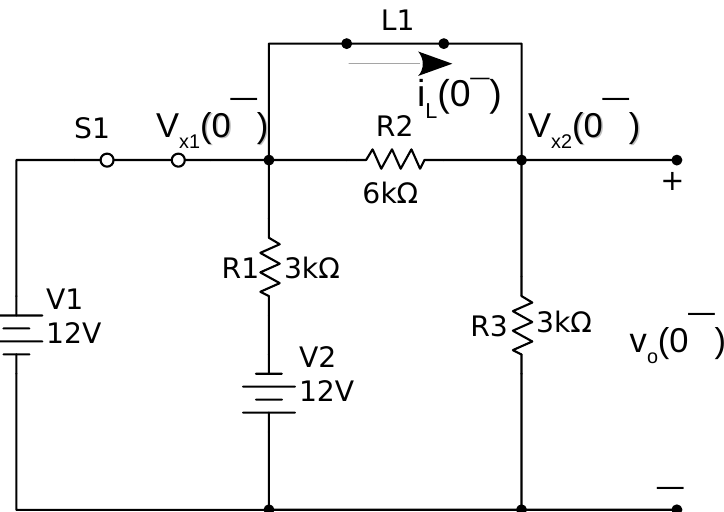
Figure 2. Switch S1 has been closed for a long time, and the circuit has attained a steady state. The inductor acts as a short circuit, and the current through the inductor is i L ( 0 − )